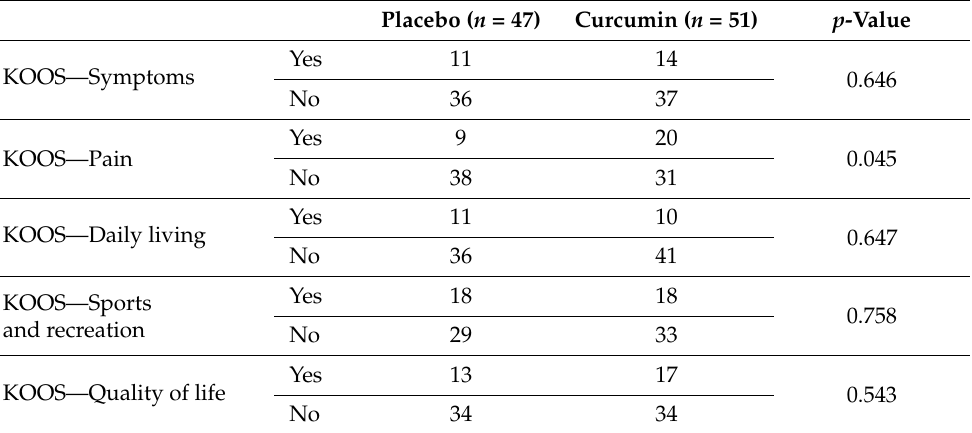
Figure 2. Mean Change in KOOS Pain Score. Data are estimates from linear mixed-effects model. Bars depict standard error. Table 3. Number of Participants Achieving Minimal Clinically Important Difference (Based on KOOS